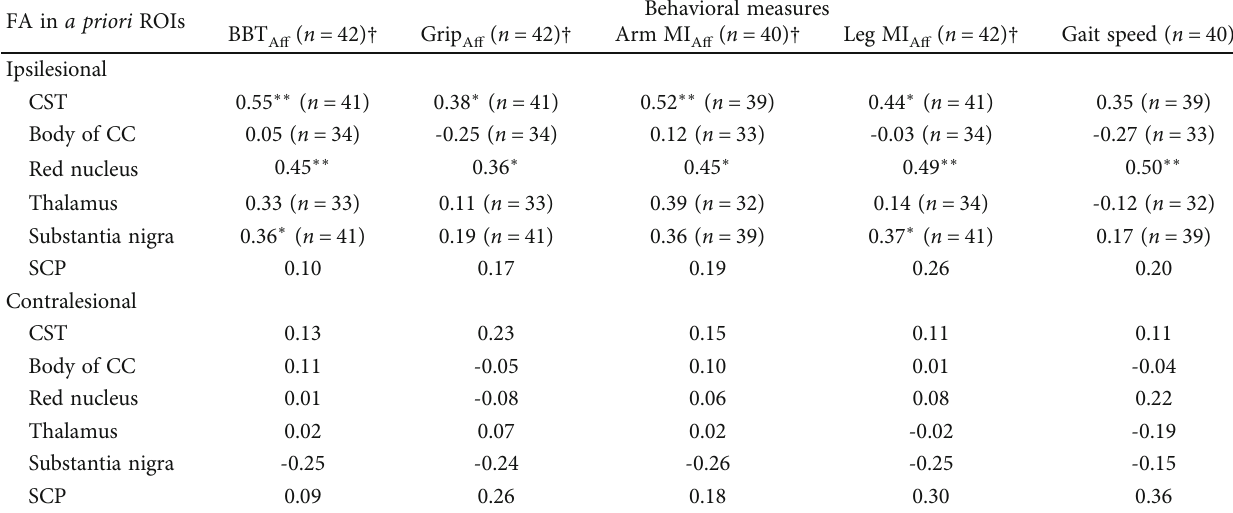
Values in the table are Spearman ’ s coe ffi cients ( r ). Abbreviations: ROIs: regions of interest; BBT A ff : Box and Block Test (a ff ected limb); Grip A ff : grip strength (a ff ected limb); Arm